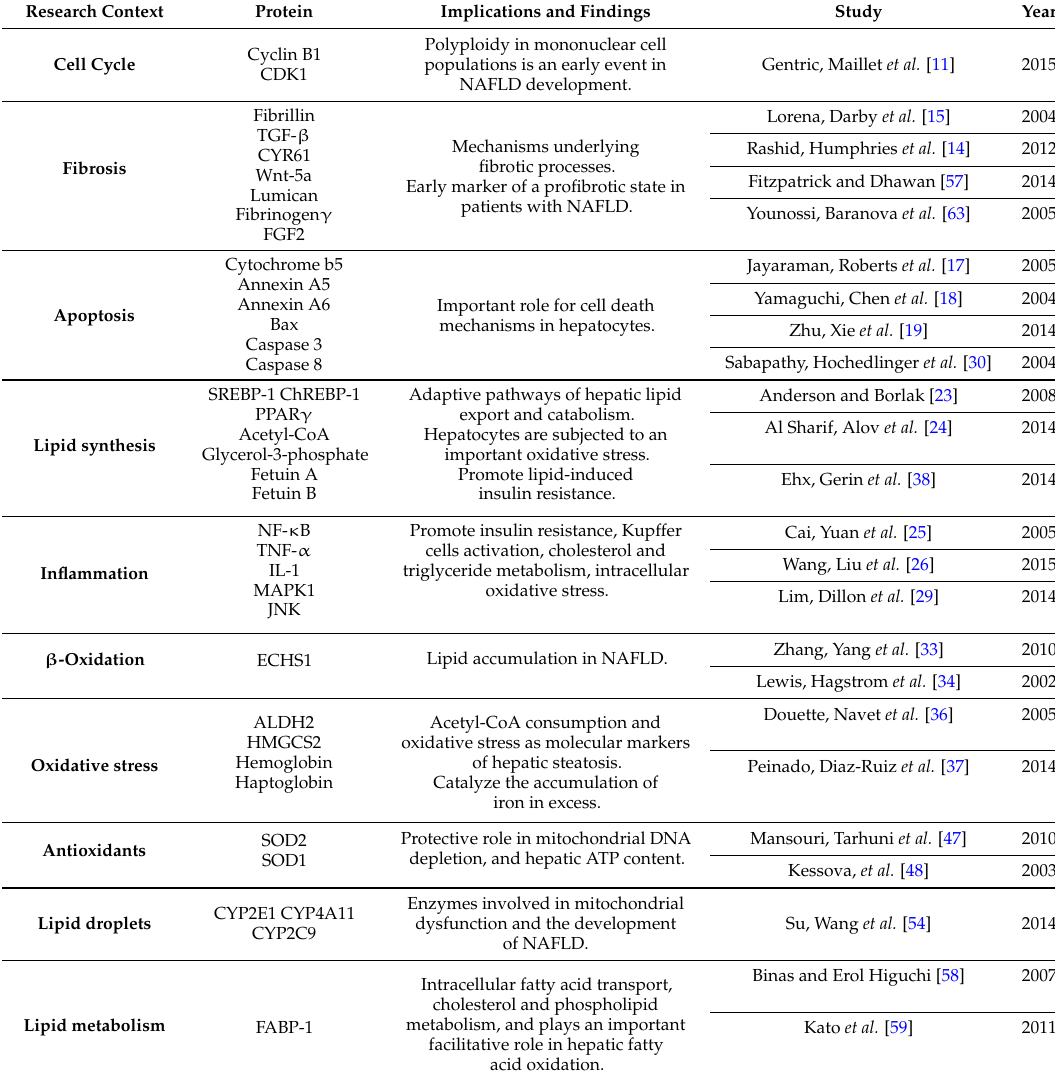
Table 1. Proteins involved in NAFLD and potential markers for